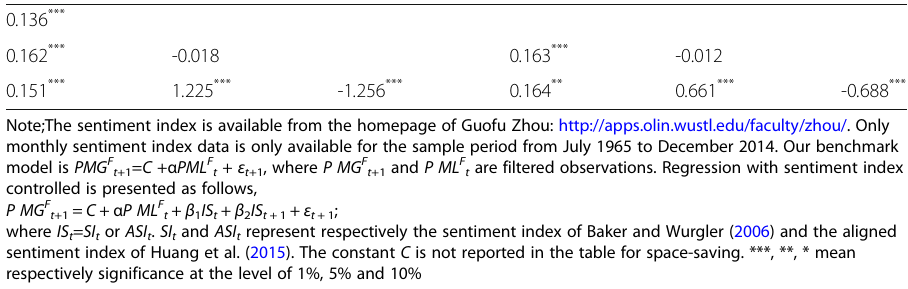
Table 16 Regression with Sentiment Index Controlled PML tF SI t SI t +1 PML tF ASI t ASI t +1 -0.018 0 . 163 *** -0.012 0 . 151 *** 1 . 225 *** -1 . 256 *** 0 . 164 ** 0 . 661 *** -0 . 688 ***